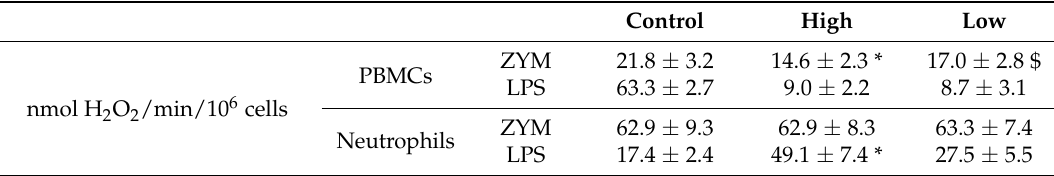
Table 3. H 2 O 2 production by PBMCs and neutrophils stimulated with LPS or ZYM after high and low H 2 O 2 treatments.